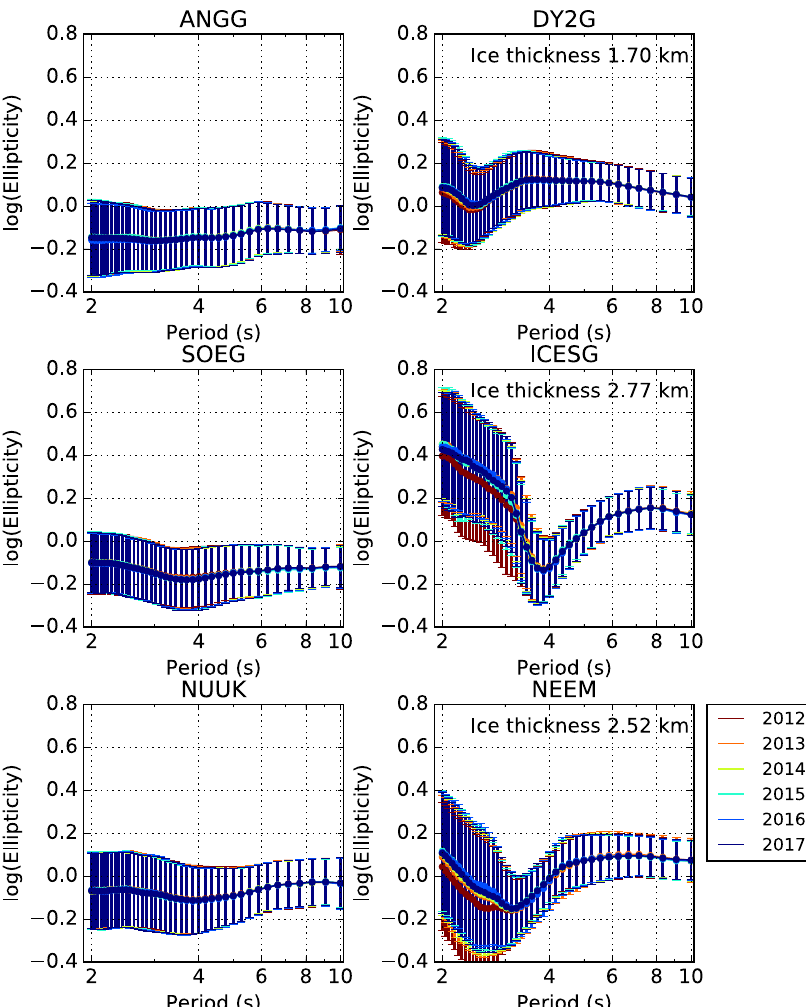
Fig. 3 Comparison of annual ellipticity measurements with a DOP ≥ 0.95 from 2012 to 2017. Left: Illustrative examples of off-ice stations. Right: Illustrative examples of on-ice stations.